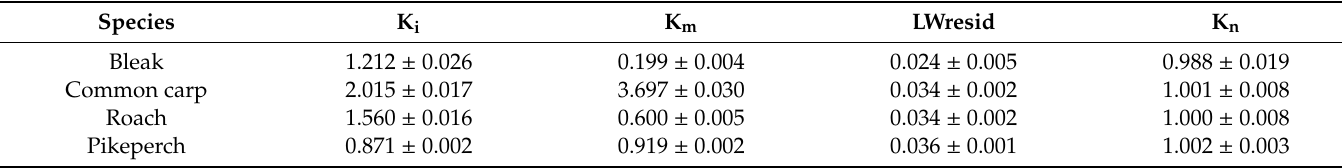
Table 2. Condition factors for each species. Fulton’s condition factor (K i ), a modification of K i (K m ), L–W relationship residuals (LWresid), and LeCren’s relative condition factor (K n ). In all cases: median value ± standard error. LWresid median was calculated by using absolute values. Species K i K m LWresid K